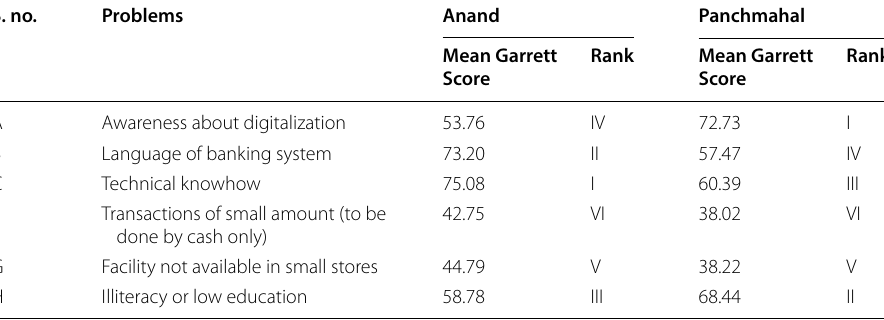
Table 15 Problems faced by farmers for moving to cashless/digital economy S.